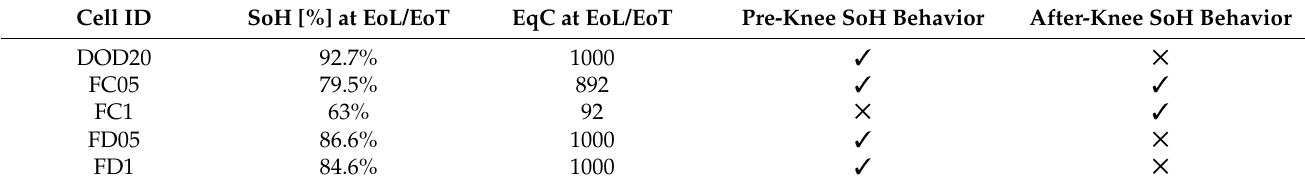
Table 3. Training subset for SoH estimation. The presence of “pre-knee” and “after-knee” SoH behavior is highlighted in the last two columns. Details about the testing protocols can be found in Table 2.